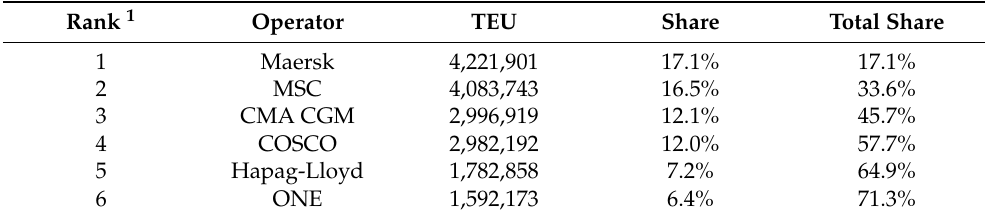
Table 2. Top 6 liner shipping operators ranked by share of TEU (twenty-foot equivalent unit of containers).